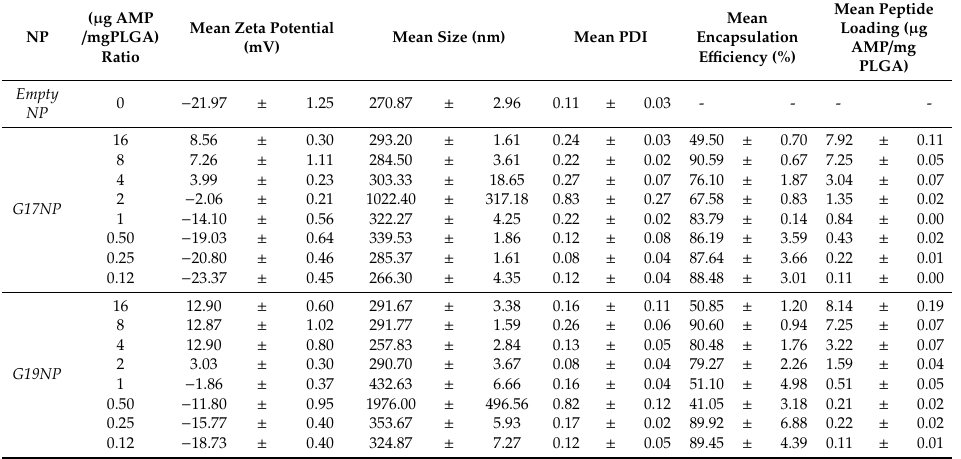
Table 2. Physicochemical properties of di ff erent AMP-NPs at di ff erent peptide / polymer ratios. ( µ g AMP Mean Zeta Potential / mgPLGA) NP (mV) Mean Size (nm) Ratio